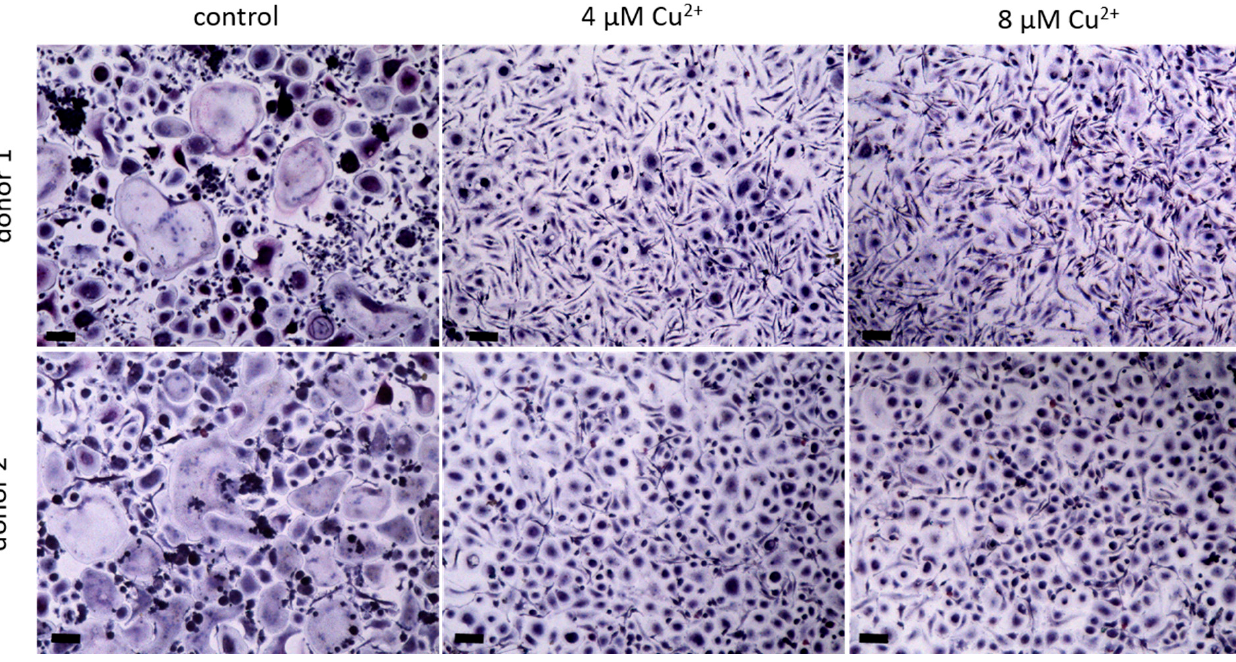
Figure 1. Cell viability of human PBMC and mature human osteoclasts after treatment with Cu 2+ . Luminescence-based CellTiterGlo ® assay was used to determine the ATP content, which correlates with the number of metabolically active cells. Cells of two donors with each n = 3 ( n = 6 in total per group) were included into the experiments. Statistic differences were calculated by one-way ANOVA, followed by Tukey’s test for multiple comparisons * p < 0.05, *** p < 0.001, **** p < 0.0001.